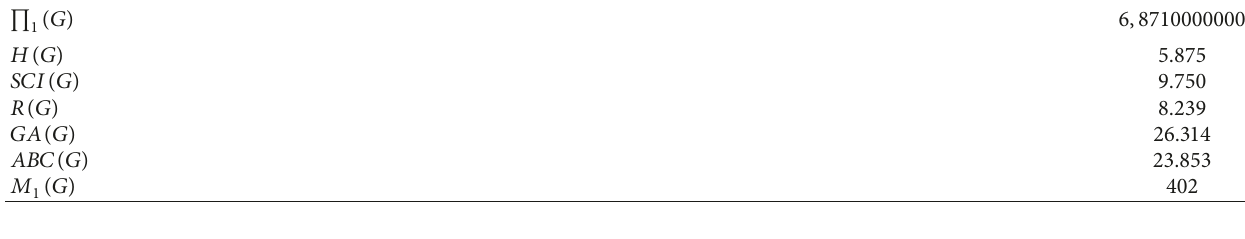
Table 2: Topological indices of G � K